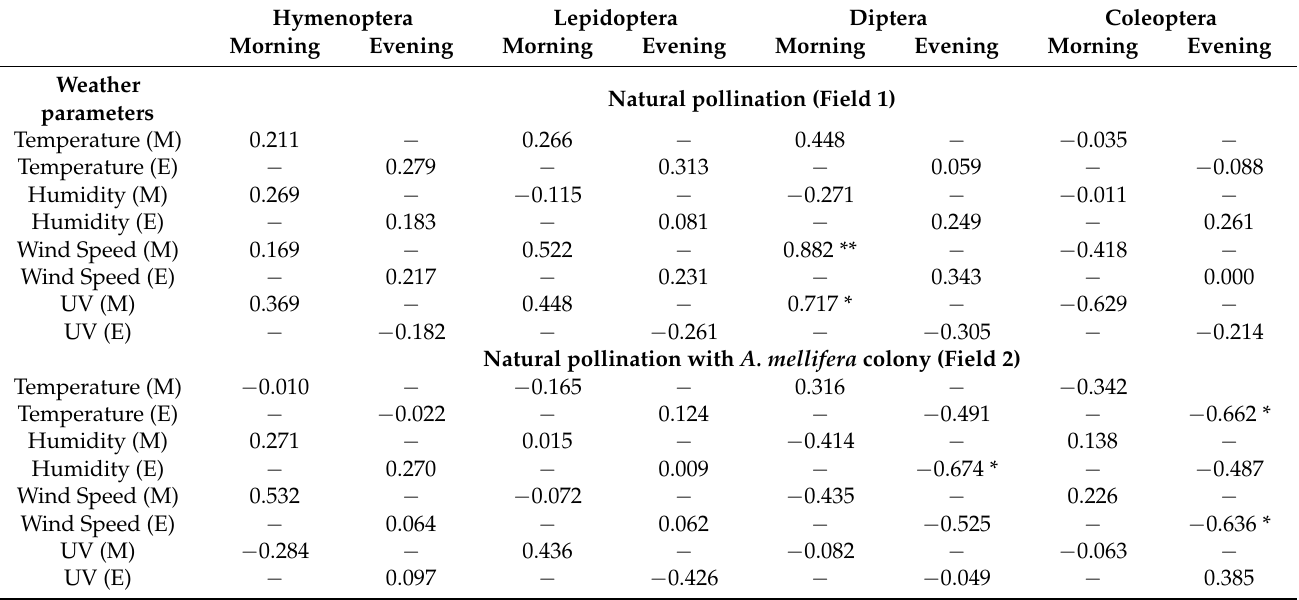
Table 3. Correlation coefficient (r) between insect pollinators/visitors and three-day weather